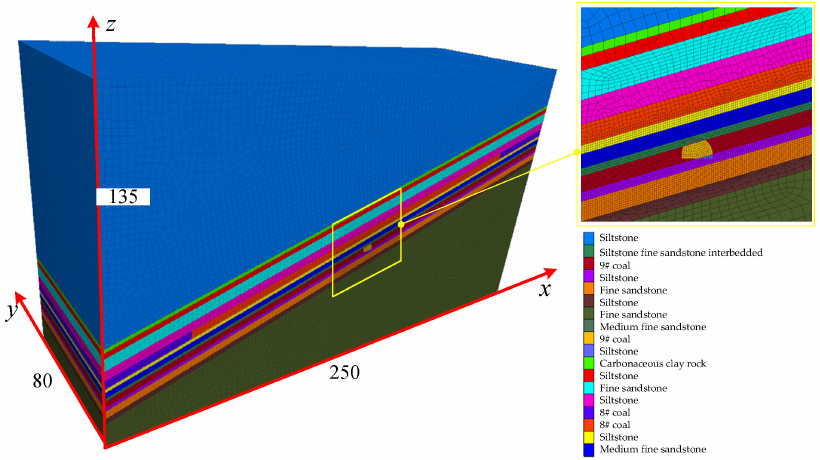
Figure 9. Numerical calculation model of a certain